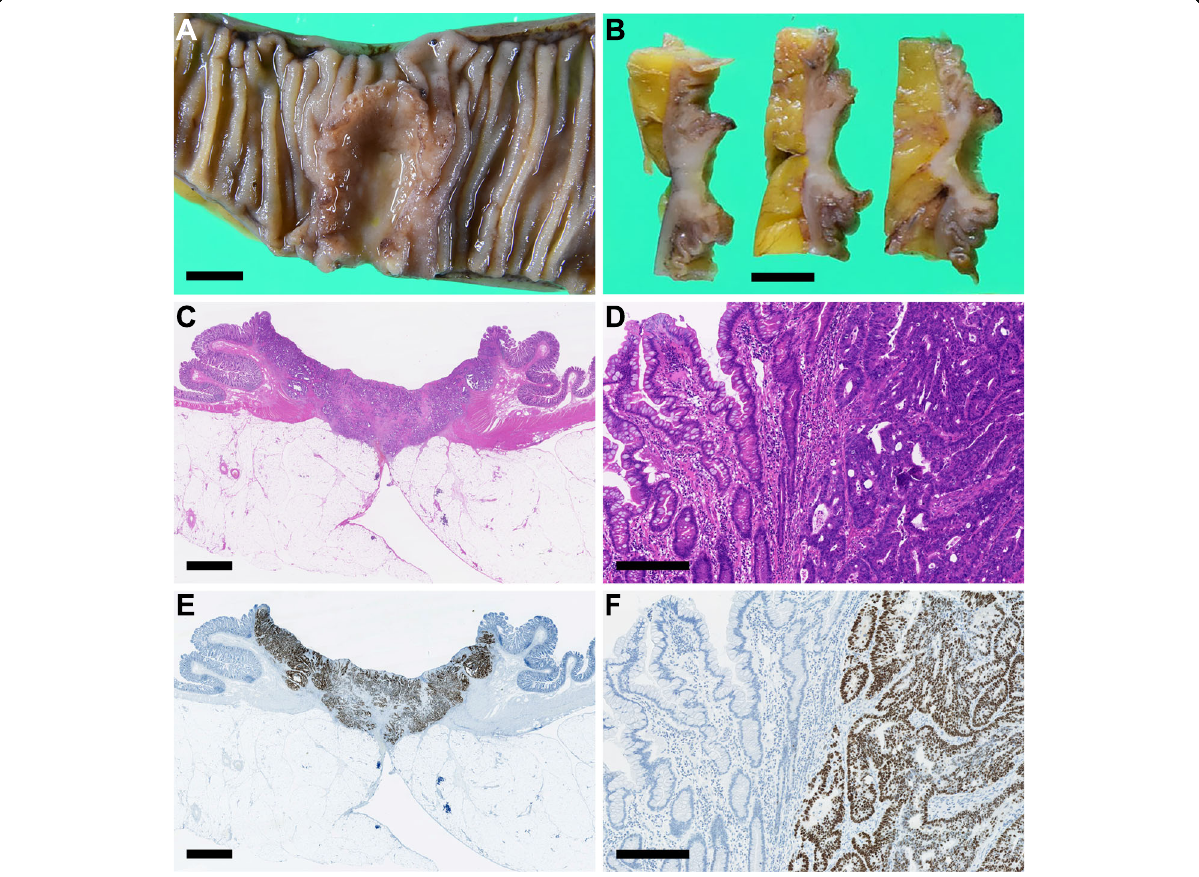
Fig. 2 The small intestinal tumor. a Surface and b slices of the tumor. c A representative whole-slide and d magnified hematoxylin and eosin staining images of the tumor. e A representative whole and f detailed images of p53 immunostaining. Black bars: 1 cm ( a , b ), 2.5 mm ( c , e ), 250 μ m ( d , f